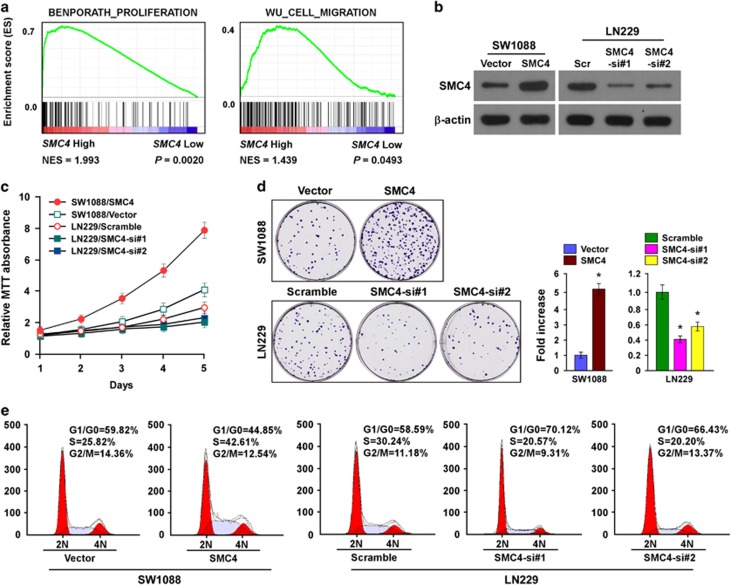
Elevated SMC4 expression promotes glioma cell proliferation and viability in vitro. (a) GSEA plot indicating a significant correlation between SMC4 mRNA expression level and the proliferation and migration gene signatures (BENPORATH_PROLIFERATION, WU_CELL_MIGRATION). (b) Western blot detection of SMC4 protein expression in SW1088 and LN229 cells. (c) MTT assay of SW1088 and LN229 cell growth curves following SMC4 or SMC4 siRNA(s) transfection. (d) Representative micrographs (left) and quantification (right) of crystal violet–stained SW1088 and LN229 cell colonies following 14-day colony formation assay. (e) Flow cytometric analysis of cellular DNA synthesis and cell cycle progression in SW1088 and LN229 cells. Bars represent the mean±s.d. of three independent experiments. *P<0.05. Scr, scramble.